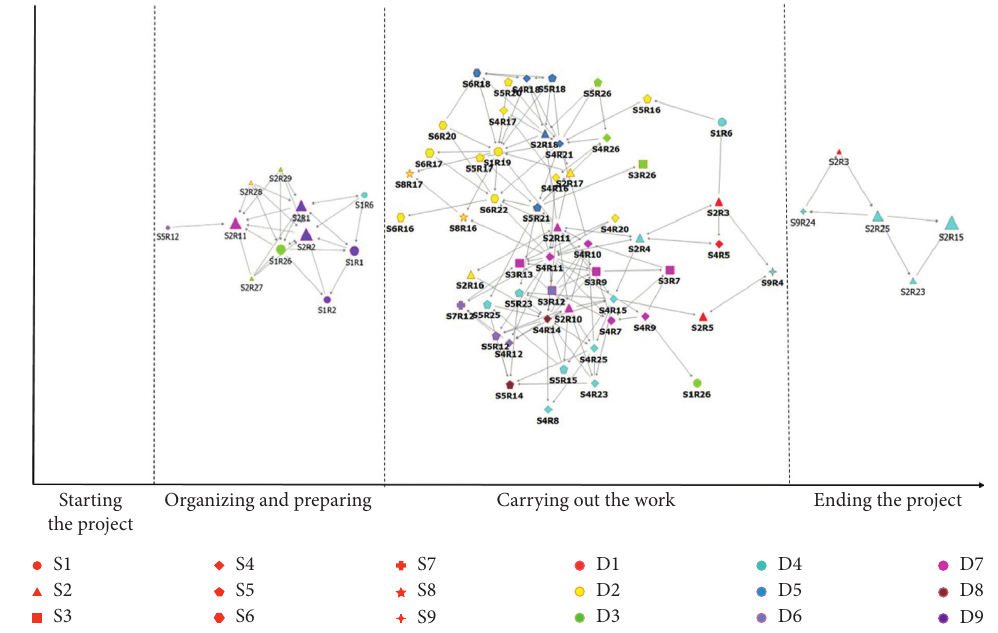
Figure 5: Phased cost risk network related to Table 5: Ranking of the key risks and interactions based on centrality.